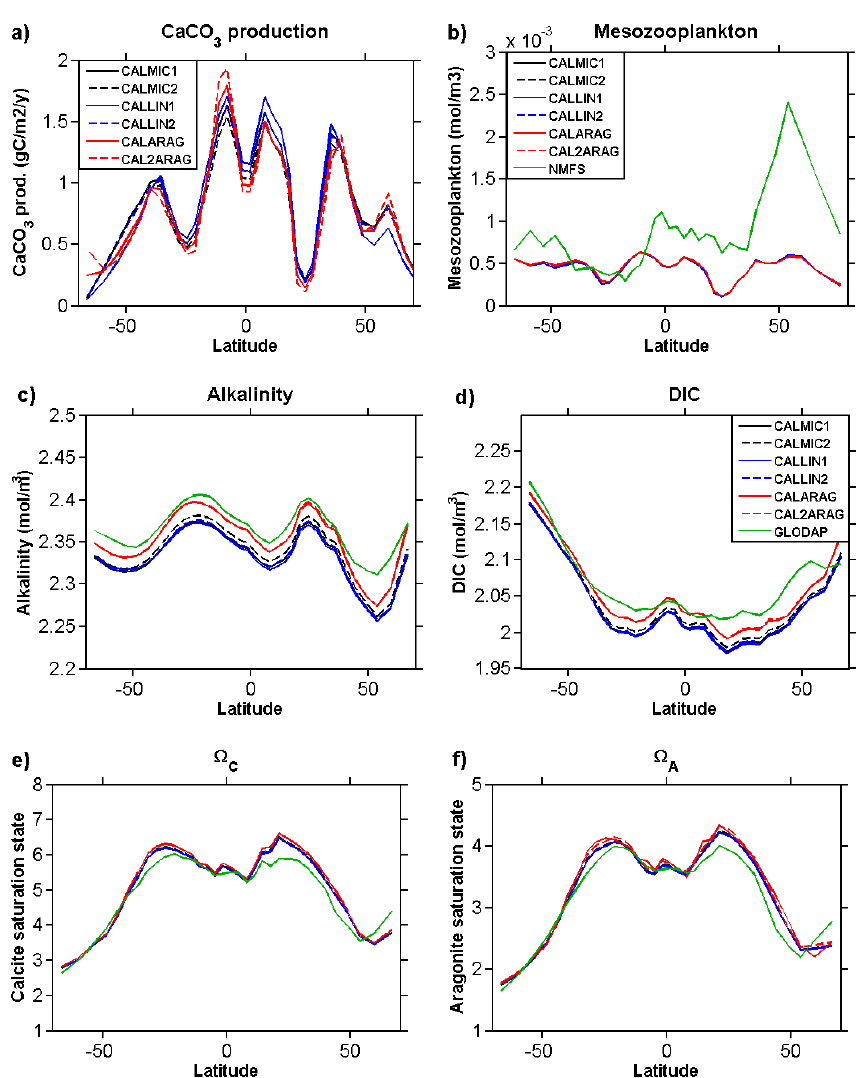
Fig. 5. Zonally-averaged (a) CaCO 3 production, (b) mesozooplankton concentration, (c) alkalinity, (d) DIC, (e) calcite saturation state and (f) aragonite saturation state for the global ocean and different parameterizations of CaCO 3 production in the Bern3D/PISCES model. Observations and observation-based estimates are shown by green lines (NMFS data set; Buitenhuis et al., 2006, and GLODAP; Key et al., 2004). All concentrations are averages over the upper 3 layers of the model, equivalent to a depth of